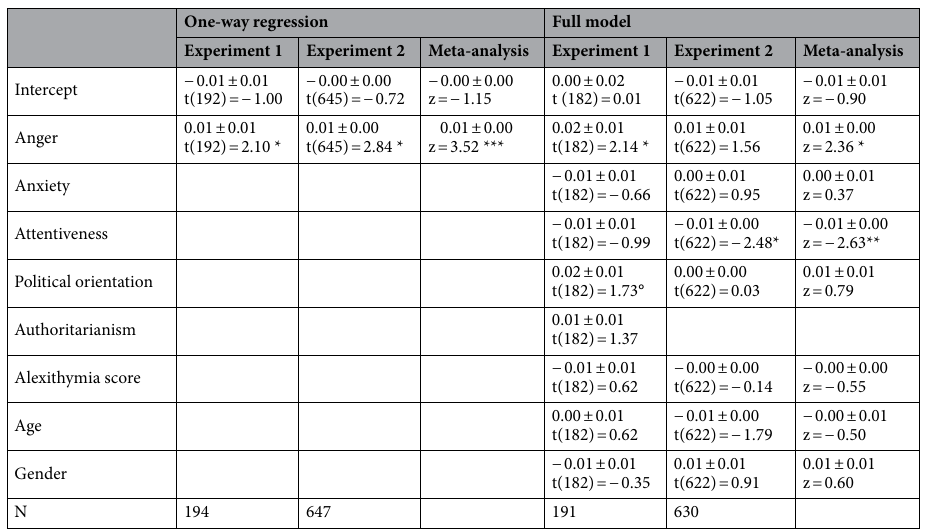
Table 2. Results of the regression analyses on the change in the preference for a strong leader after the anger induction in Experiments 1 and 2. The first line corresponds to the standardized regression coefficient, presented with the standard errors to the mean. N corresponds to the number of participants included in each regression (without missing data). ***indicates a p-value < .001, **indicates a p-value < .010, *indicates a p-value < .050 and °indicates a p-value <